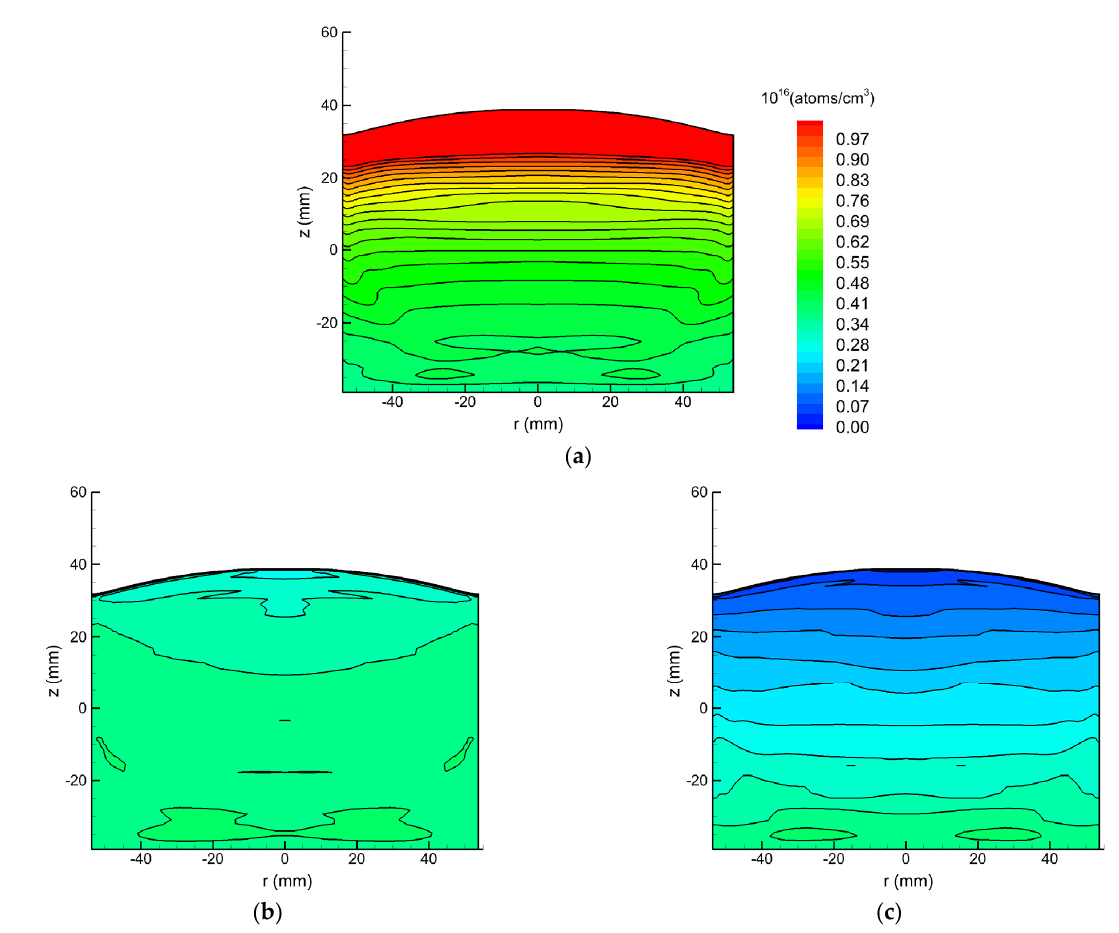
Figure 3. Temperature distribution and flow field in the melt and crystal with a solidified fraction of ( a ) 20%, ( b ) 50% and ( c ) 80%.